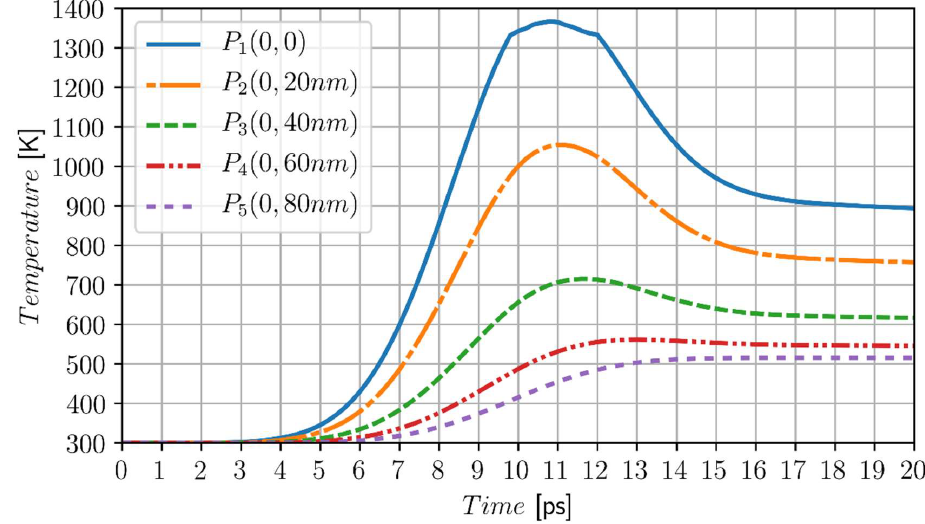
Figure 7. Temperature history at the points P 1 (0, 0), P 2 (0, 20 nm), P 3 (0, 40 nm), P 4 (0, 60 nm) and P 5 (0, 80 nm), gold, I 0 = 5 × 10 4 J/m 2 , t p = 5